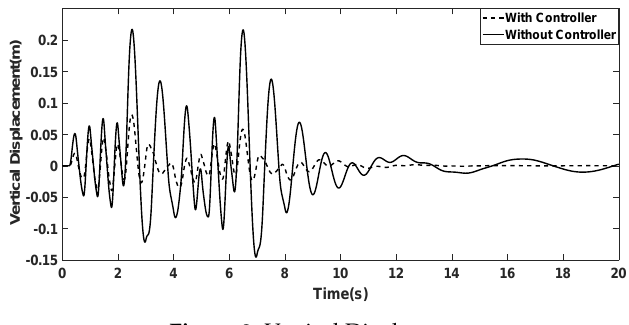
Figure 9. Vertical Displacement.